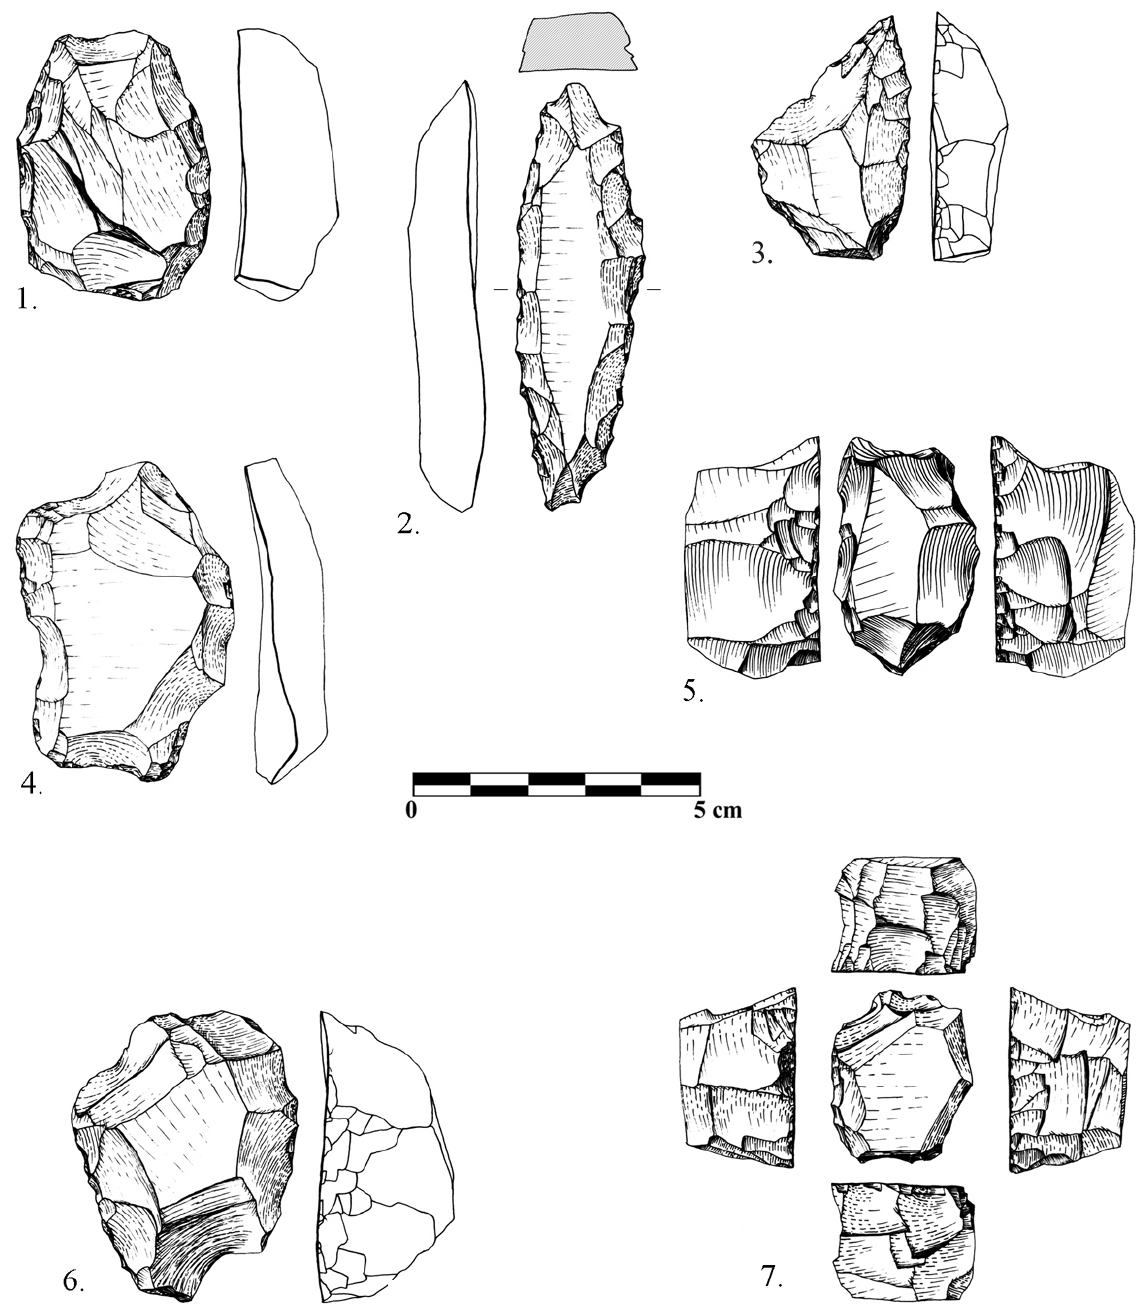
Figure 10. Exemples de pièces façonnées unifacialement dénaturées. Figure 10. Examples of exhausted unifacially shaped